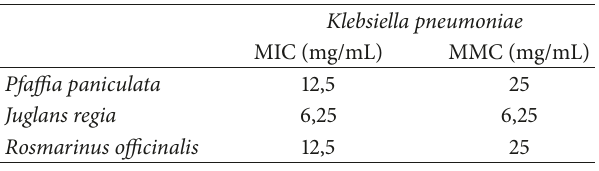
Table 1: Broth microdilution test results with concentrations corre- sponding to MIC and MMC for each extract.